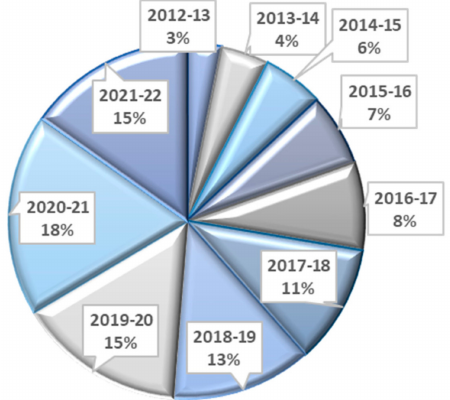
Figure 4. Number of review articles on nanocatalyzed heterocyclic